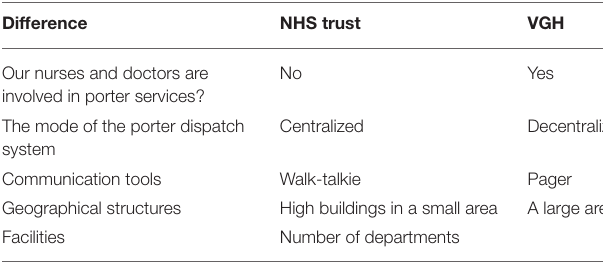
TABLE 2 | Illustration of the differences between NHS trust and VGH. Difference NHS trust